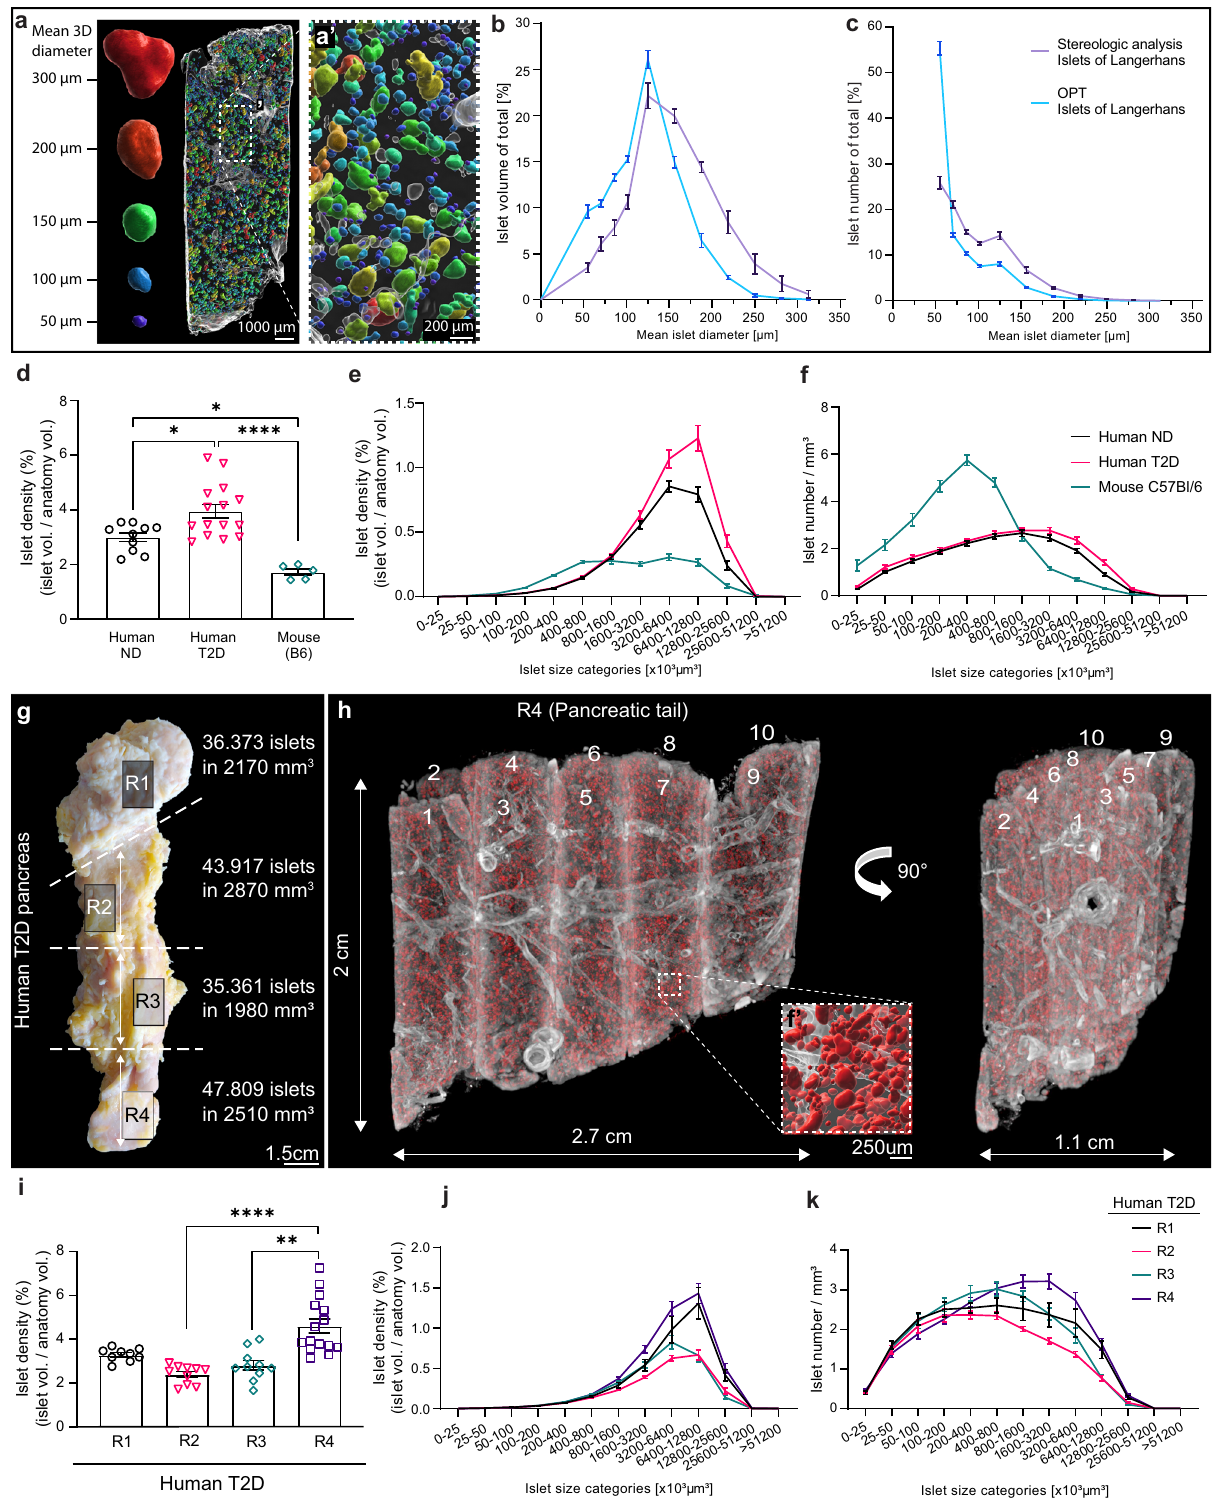
(ND) donor and re-calculated the individual islets 3D volumes to their average diameters to compare our data sets with stereo- logical data (see methods). Assessments of the islets cross- sectional diameters showed no difference between OPT, LSFM, and histological tissue sections of the same specimens (Supple- mentary Fig. 3, p > 0.8, mean diameter difference − 3.62% and 0.137% for OPT and LSFM versus sections respectively). COMMUNICATIONS BIOLOGY| (2021) 4:1063